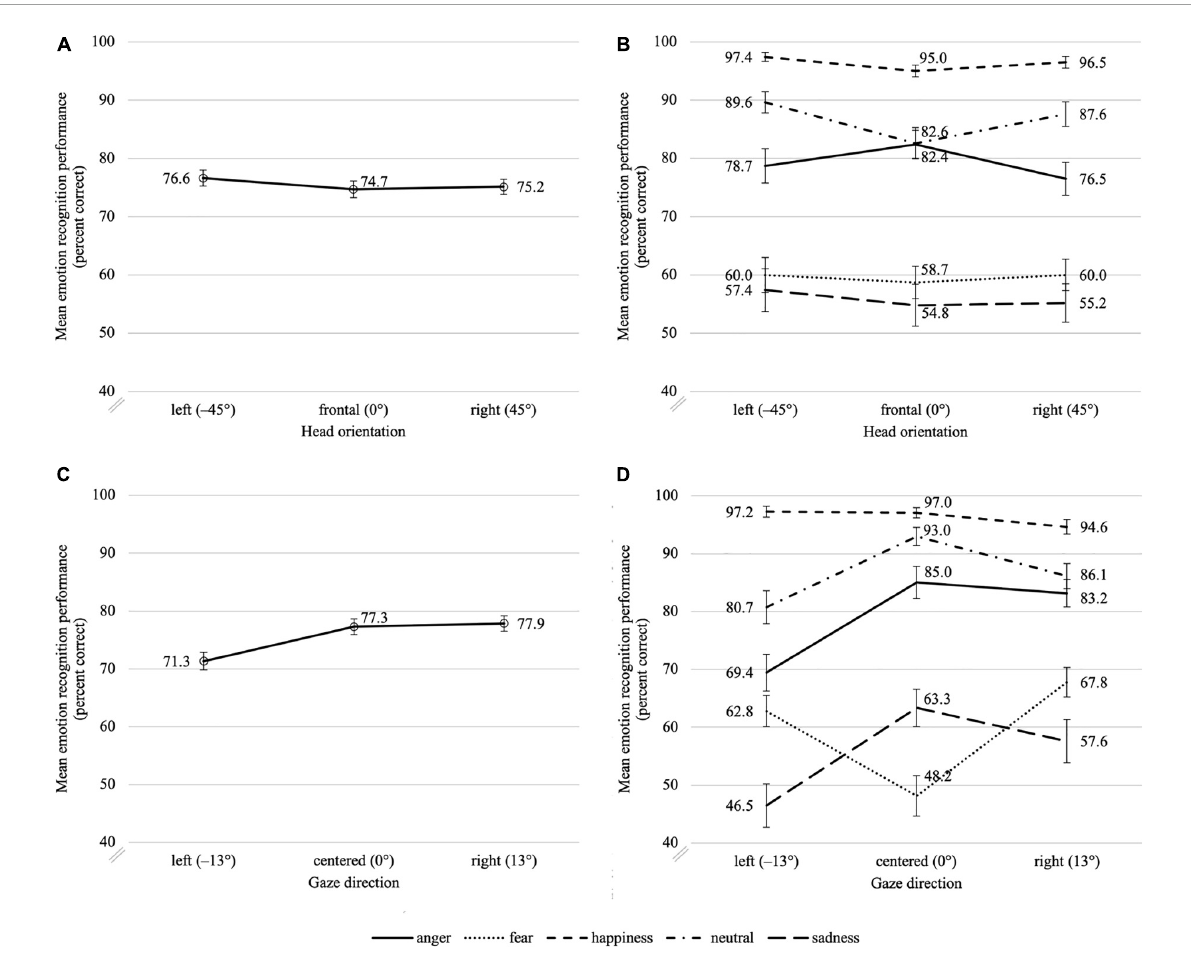
FIGURE8 Mean emotion recognition performance in percent correct for masked faces as a function of head orientation (top row, A,B ) and gaze direction (bottom row, C,D ), aggregated across all facial expressions (left column, A,C ) and additionally as a function of the five different facial expressions (right column, B,D ). Error bars indicate the standard error of the mean (SEM) of the 39 and 45 individual data points in each condition,